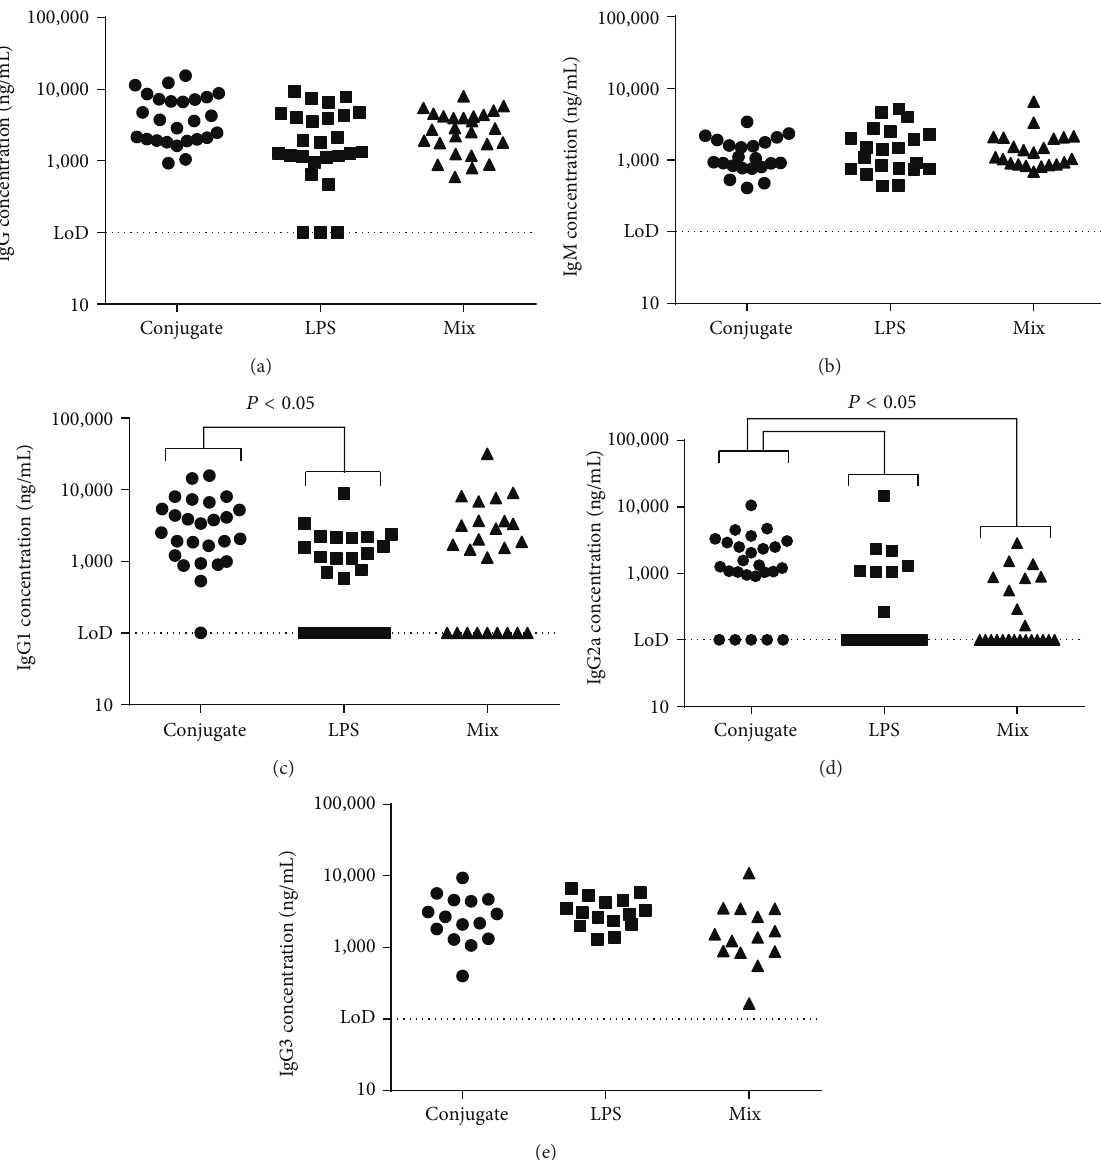
Figure 3: Antibody concentrations in serum following vaccinations. Animals received three vaccinations at two-week intervals each of 10 𝜇 g of either the TetH c -LPS conjugate ( ∙ ), LPS alone ( ◼ ), or a mix of unconjugated LPS and TetH c ( 󳵳 ). Tail bleeds were performed four weeks after the final vaccination and ELISA performed to detect antibodies specific for B. pseudomallei LPS. Data is shown for replicate studies and shows the calculated concentration of total IgG (a), total IgM (b), IgG1 (c), IgG2a (d), and IgG3 (e). Data was analysed by a univariate linear model. Significant differences are shown. Where no markers are present, 𝑃 was greater than